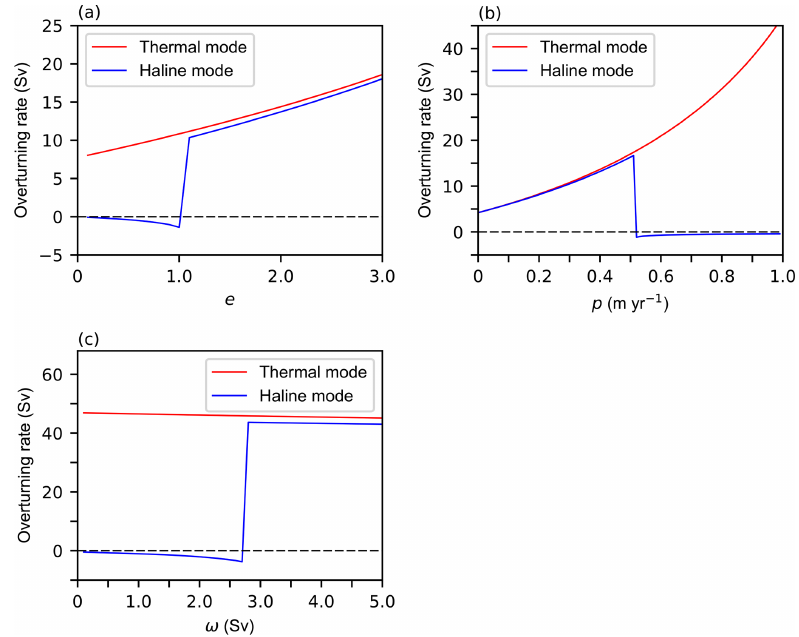
Figure 3. Variations of overturning rates in the space of (a) energy constraint parameter e , (b) freshwater flux p and (c) wind-driven circulation ω in the three-box model with (a) p = 0 . 5myr − 1 and ω = 1 . 5Sv, (b) e = 2 . 5 × 10 − 7 kgm − 2 s − 1 and ω = 0 . 0Sv, and (c) e = 2 . 5 × 10 − 7 kgm − 2 s − 1 and p = 1 . 0myr − 1 . The red line indicates the stable thermal mode and the blue line indicates the stable haline mode. The dashed black line is a division line between the thermal-mode equilibrium state and the haline-mode equilibrium